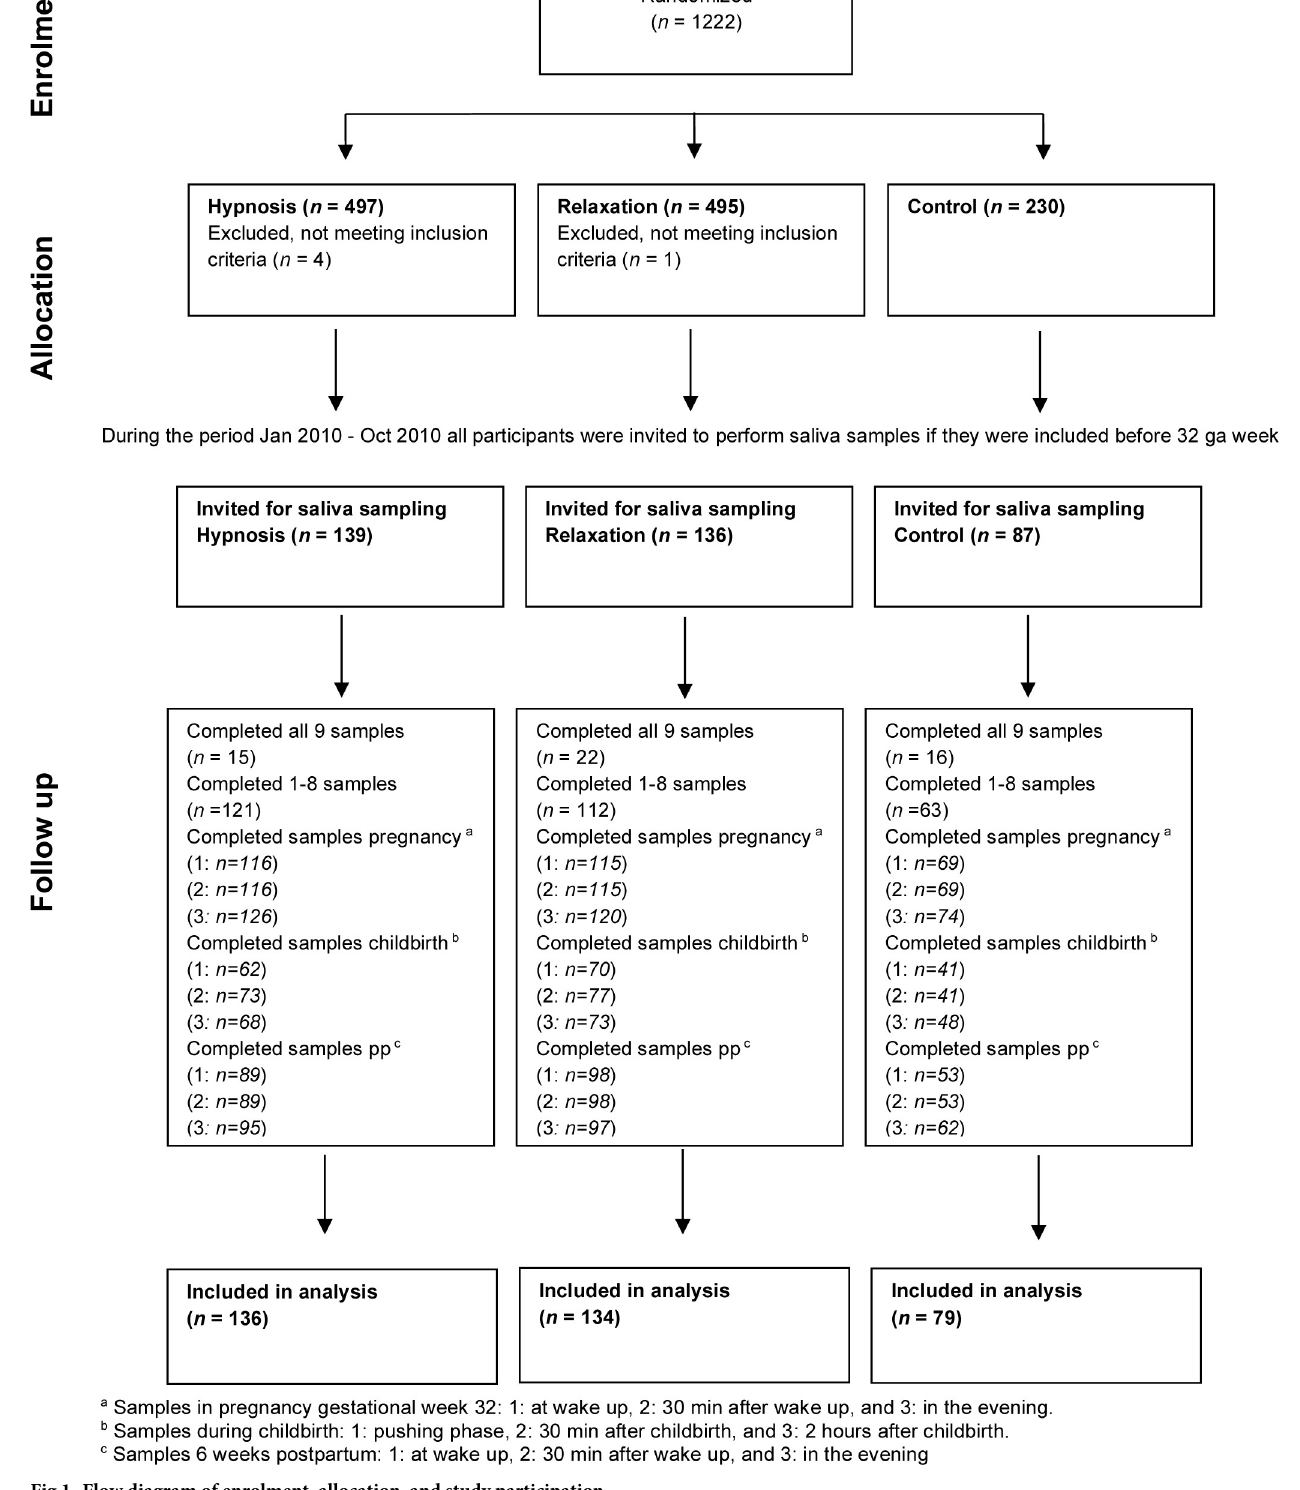
PLOS ONE | https://doi.org/10.1371/journal.pone.0230704 May 1,